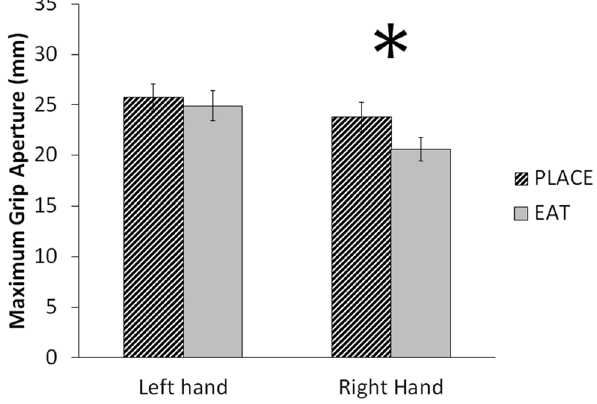
Figure 2. Hand 6 Task interaction on MGA. Values shown are means + standard errors. PLACE and EAT conditions were significantly different from each other in right-handed movements only; left-handed movements were not significantly affected by